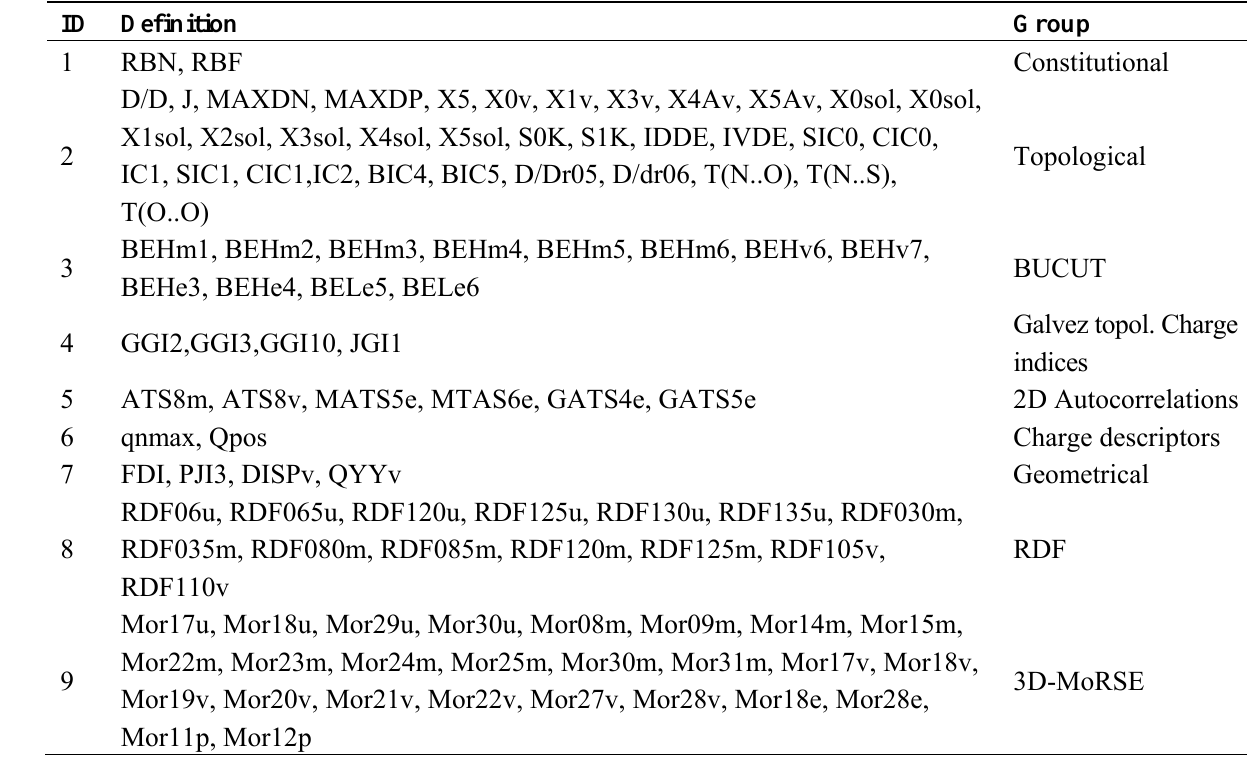
Table 13. Physcicochemical, topological and structural